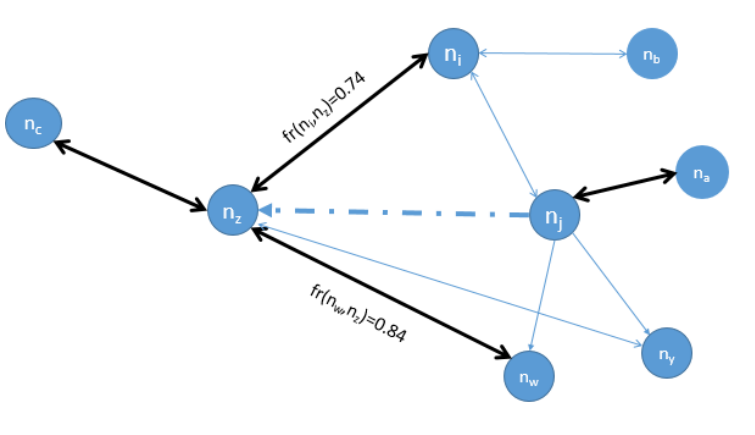
Figure 4. A network portion of